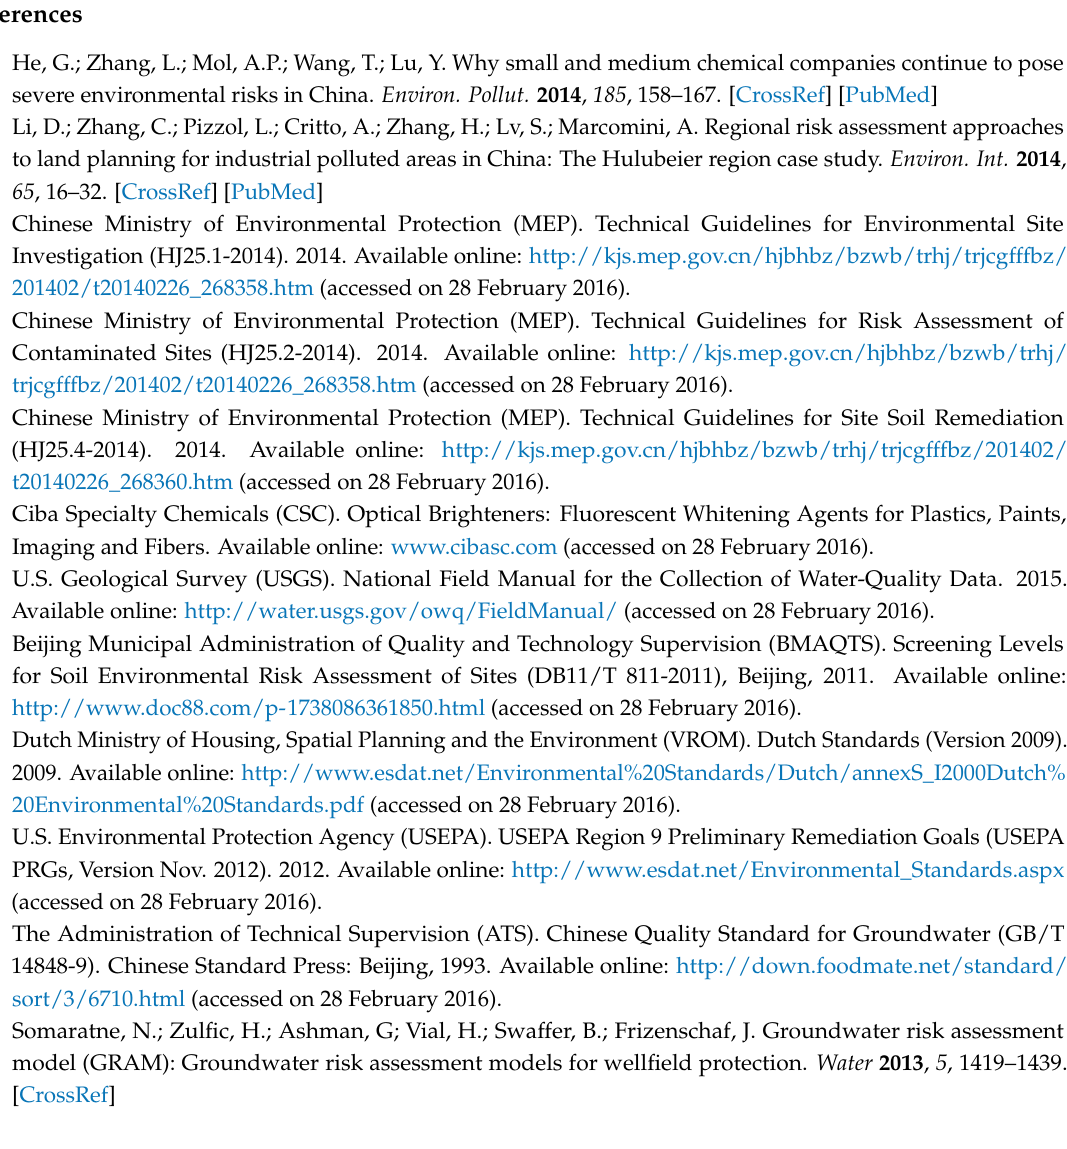
Supplementary Materials: The following are available online at www.mdpi.com/2073-4441/9/9/657/s1, Part A:Tables, Table S1: Lab analytical method for investigations at the Luhe site, China., Table S2: Heavy metals of soil samples in garden plot at the Luhe site, Nanjing, China (Unit: mg/kg in dry weight), Table S3: Calculation of Exposure rate based on non-carcinogenic effects of COCs at the Site, Table S4: Calculation of Exposure rate based on carcinogenic effects of COCs at the Site, Table S5: Toxicity parameters of COCs at the Site., Table S6: Physical and chemical properties, and other relevant parameters for COCs at the Site; Part B: Models, Part B1: Models for calculating exposure rate based on non-carcinogenic effects and carcinogenic effects, Part B2: Models for toxicity assessment, Part B3:Models for calculation of hazard quotient and carcinogenic risk, Part B4: Models for calculating risk control values based on non-carcinogenic effects and carcinogenic effects, Part B5: Models for analysis on risk exposure contribution; Part C: Risk-based Parameters and values; Part D: List of other Risk-based